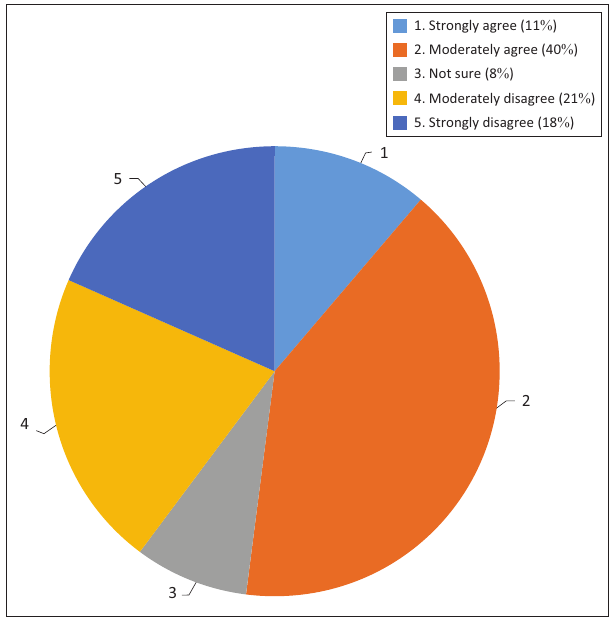
FIGURE 1: Availability of policies to respond to climate change adaptation. FIGURE 2 : Policies adequately address climate change adaptation